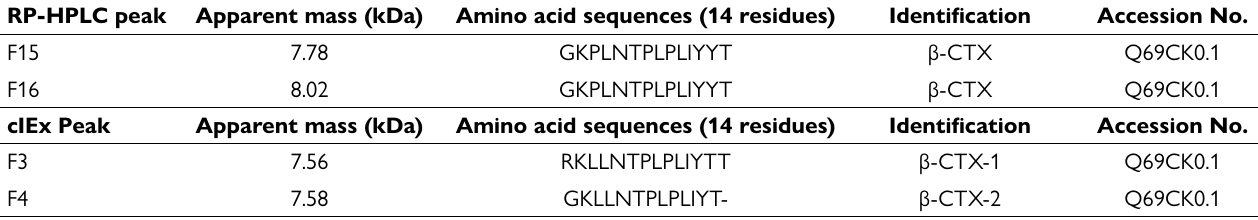
Table 1. N-terminal sequence results representing amino acid residues of β-CTX found from the isolation RP-HPLC peak